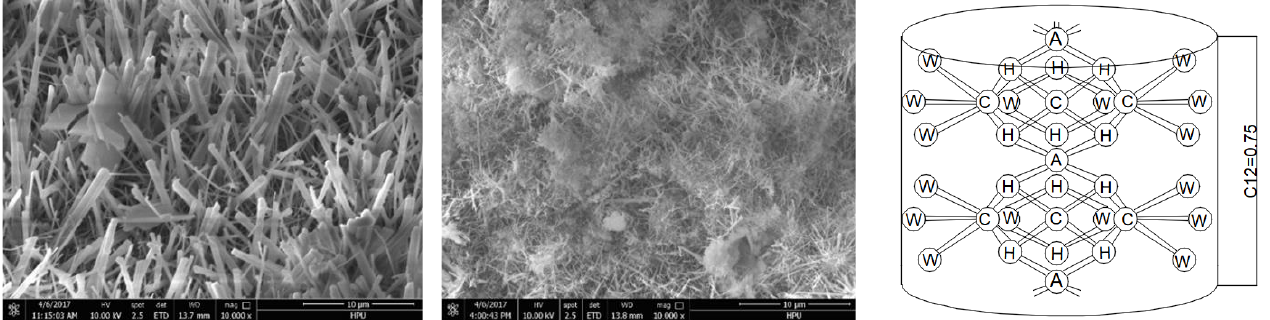
Figure 23. Microstructural diagram of high-water material after a hydration reaction (1 d, 3 d, and 7 d). Molecular structure of ettringite in high-water consolidation (A-Al, C-Ca, H-OH, and W-H 2 O)